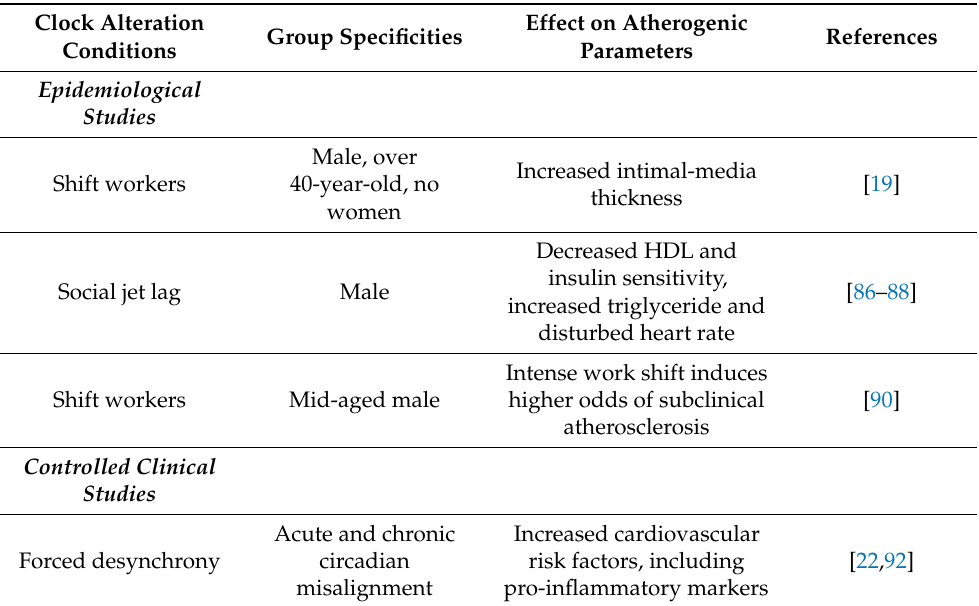
Table 1. Clock alteration on atherogenesis in epidemiological and controlled clinical